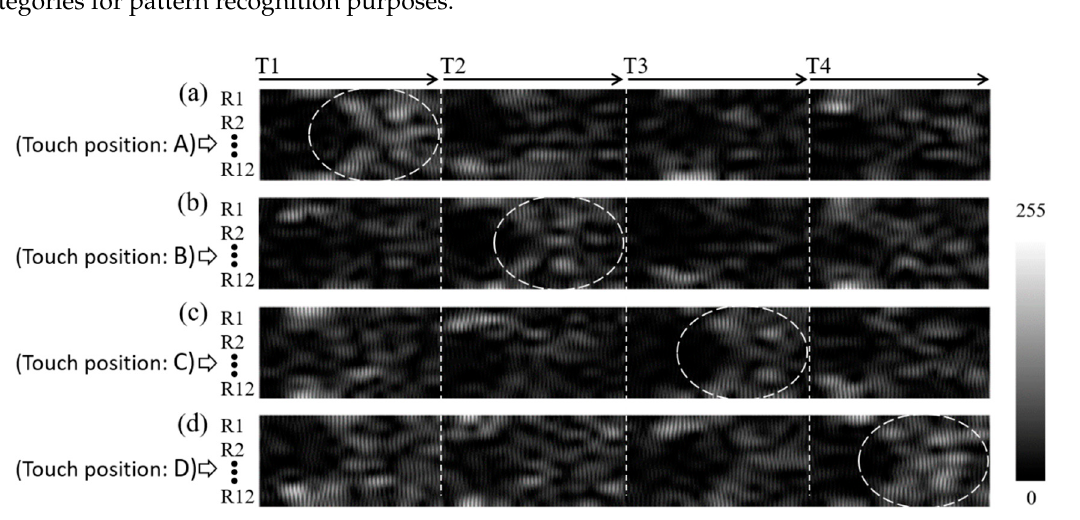
Figure 12. Experimentally obtained waveform data images for touch positions ( a ) A, ( b ) B, ( c ) C, and ( d ) D as shown in Figure 11,